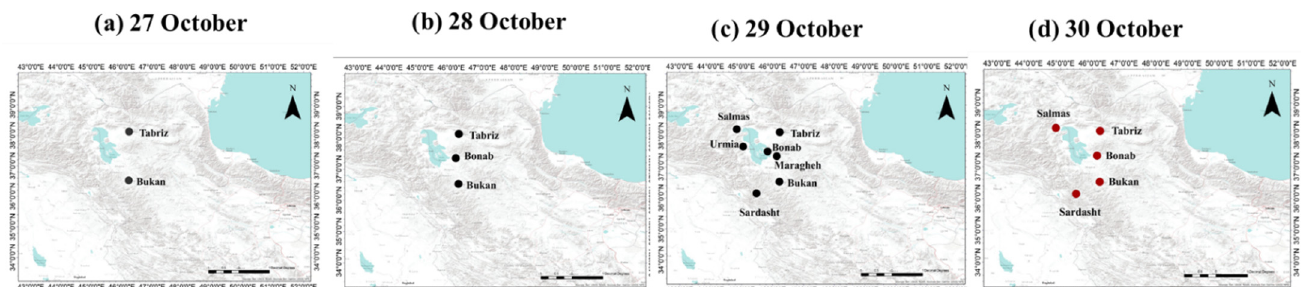
Figure 7. The weather stations that reported dust related codes data around Lake Urmia on ( a ) 27 October ( b ) 28 October ( c ) 29 October ( d ) 30 October 2017.